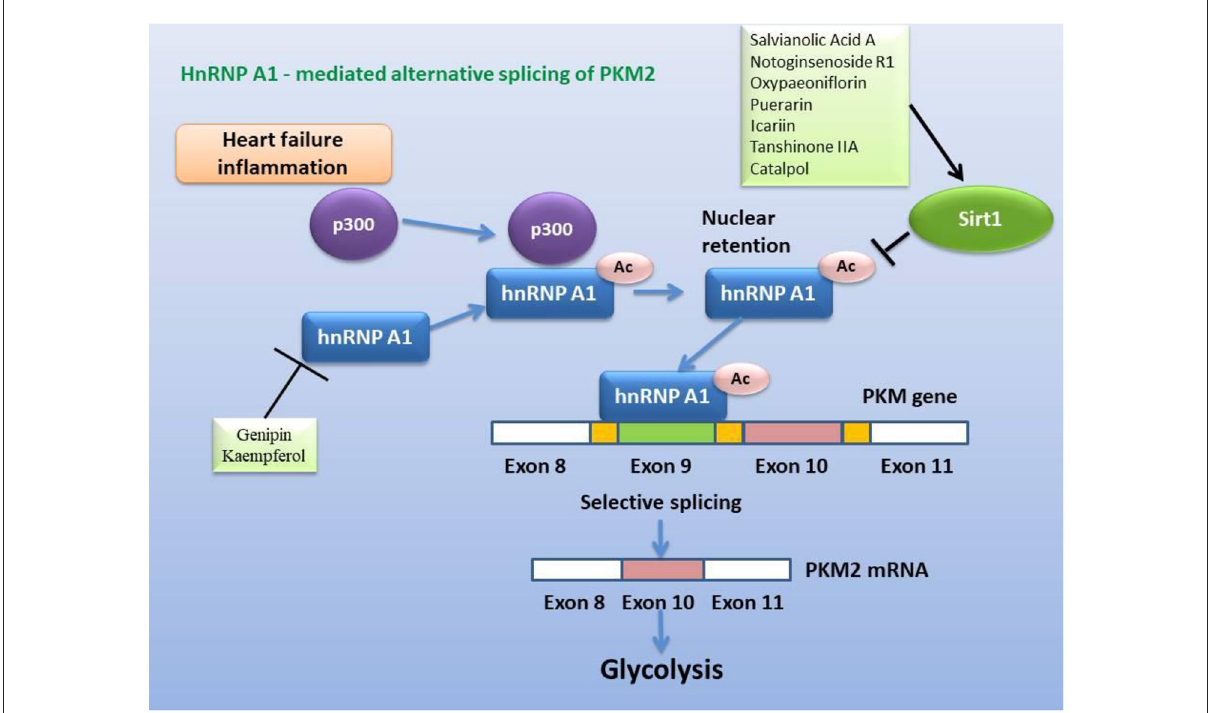
FIGURE7 Inhibitory effect of active ingredients in classical recipes on hnRNP A1-mediated alternative splicing of PKM2, either directly or via activation of Sirt1. The heterogeneous nuclear ribonucleoprotein, which packs newly produced precursor mRNA, is acetylated and stabilized under conditions of heart failure and inflammation, and then selectively splices PKM2 mRNA to promote